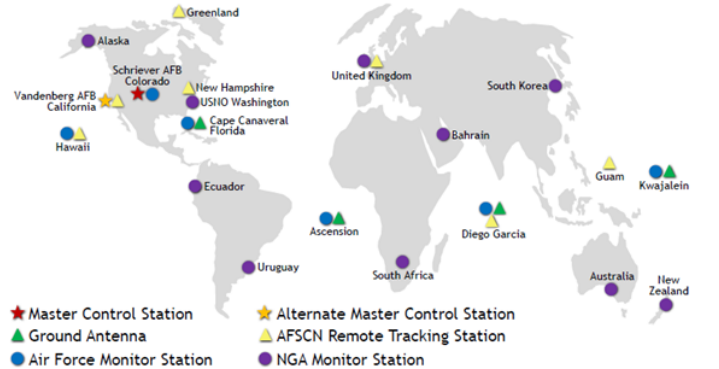
Figure 10. GPS control segment (https://www.gps.gov/multimedia/images/GPS-control-segment- map.pdf (accessed on 12 January 2022), Updated May